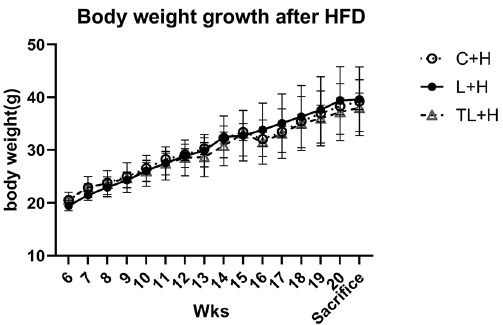
Figure 1. Postnatal body weights of the pups from different treatment groups. At the time of initial sampling, there were no significant differences in the bodyweights between the high-fat diet groups. The birth weight was not measured to reduce maternal stress. Data are presented as mean ± standard deviation, n = 4–7/group. A two-way repeated analysis of variance with a post hoc Tukey test was used for multiple comparisons. C + H